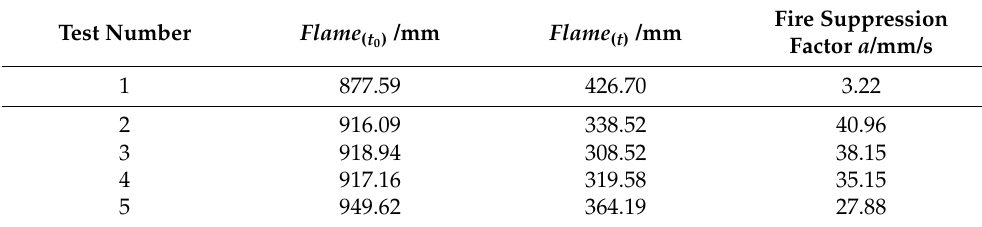
Table 3. Fire suppression efficiency under different working